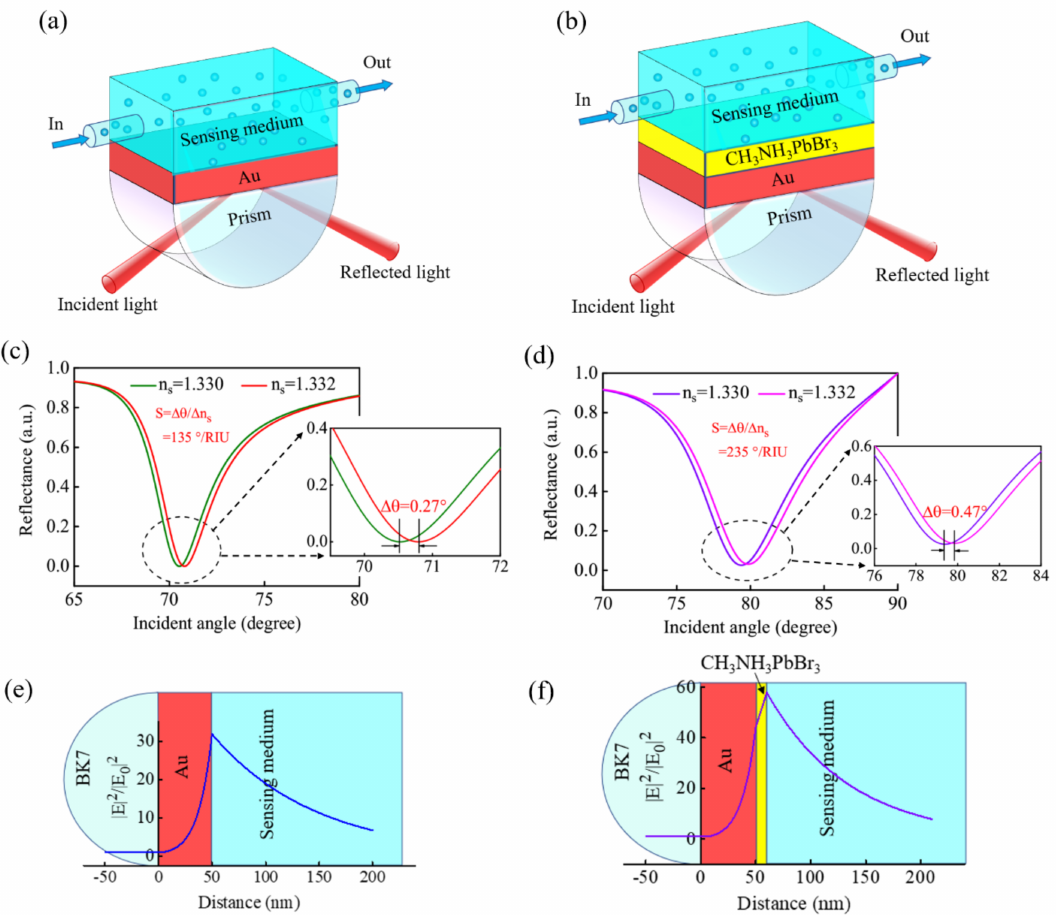
Figure 2. ( a ) Schematic diagram of the conventional Au-based SPR biosensor. ( b ) CH 3 NH 3 PbBr 3 perovskite as a guided- wave layer to coat on the surface of Au-based SPR biosensor. ( c ) The sensitivity of the conventional Au-based SPR Biosensor at λ = 633 nm. ( d ) The sensitivity enhanced by a 10 nm thick CH 3 NH 3 PbBr 3 perovskite thin film in Au-based SPR biosensor. ( e ) The electric field distribution of the conventional Au-based SPR biosensor. ( f ) The SPR sensor using the guided-wave layer of CH 3 NH 3 PbBr 3 perovskite thin film to enhance the electric field at the sensing